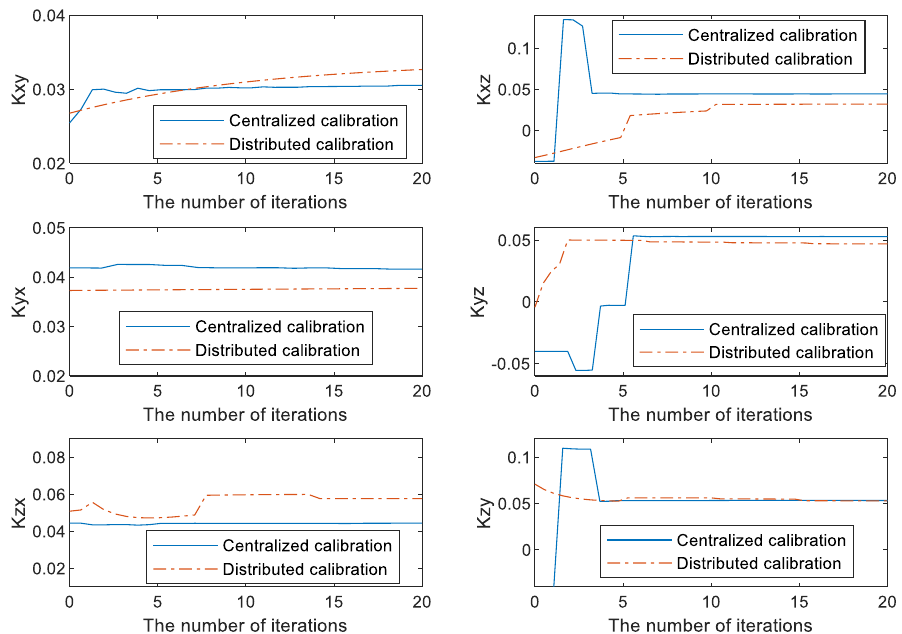
Figure 3. Gyroscope zero − bias estimation results.